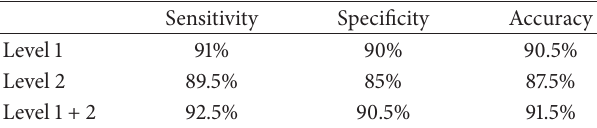
Table 6: Results obtained using the proposed feature in V